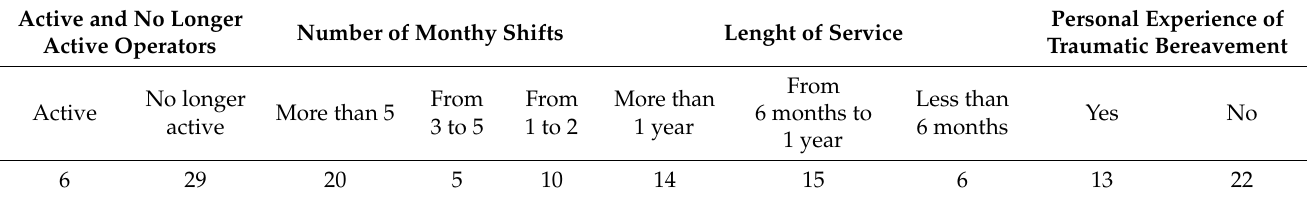
Table 1. Characteristics of participants ( n =